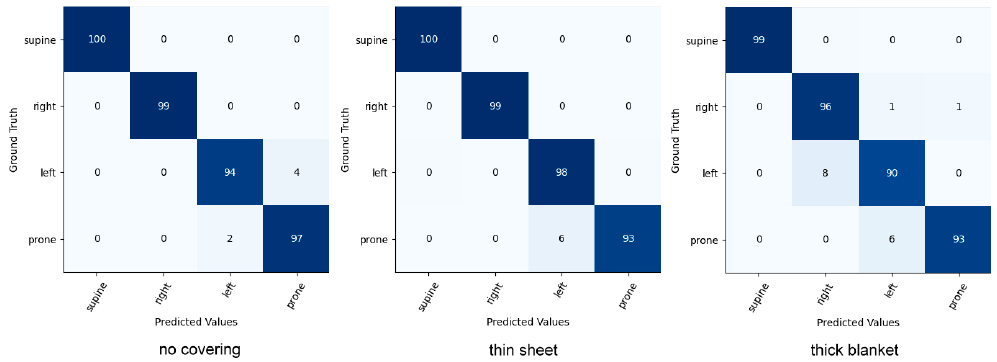
Figure 11. Confusion matrix for upper-body pose classification on the iSP pilot dataset.